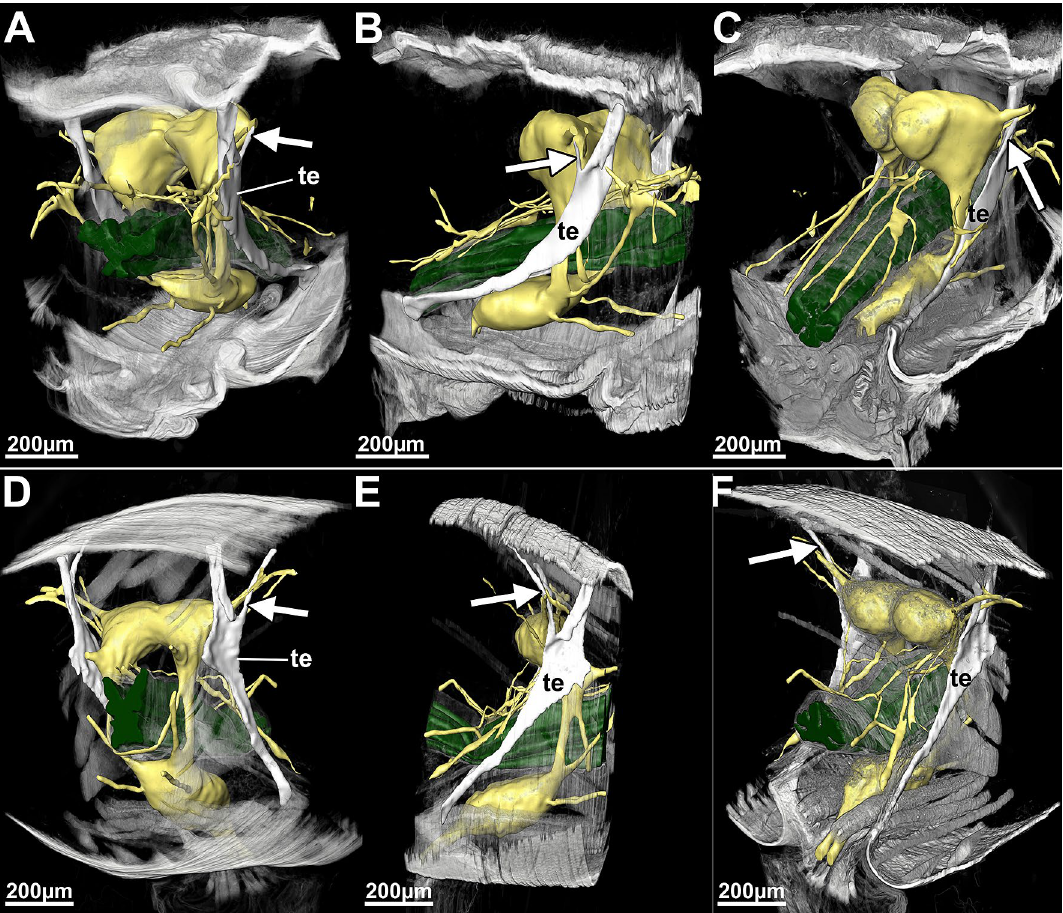
Figure 7. Visualization and comparison of the secondary supratentorial branch of Drusus bosnicus ( D – F ) which is missing in D. discolor ( A – C ) (indicated with an arrow) based on histological sections. Abbreviations: te = tentorium. central nervous system including cerebral ganglion mass, gnathal ganglion mass, frontal ganglion and innervation patterns in yellow. The figure was built using the visualization software Amira 2020.2 (Thermo Fisher Scientific, https:// www. therm ofish er.